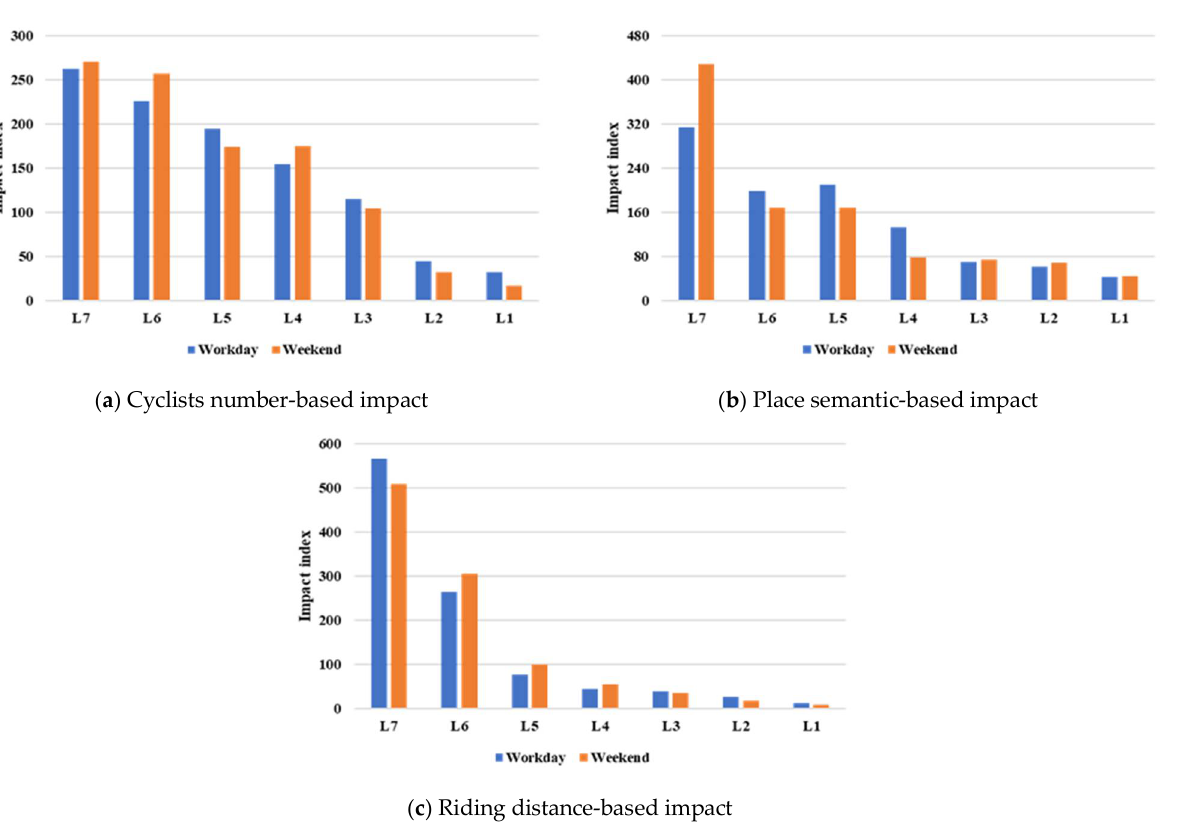
Figure 10. Statistical results of the number of docking stations with different affected levels from three dimensions.